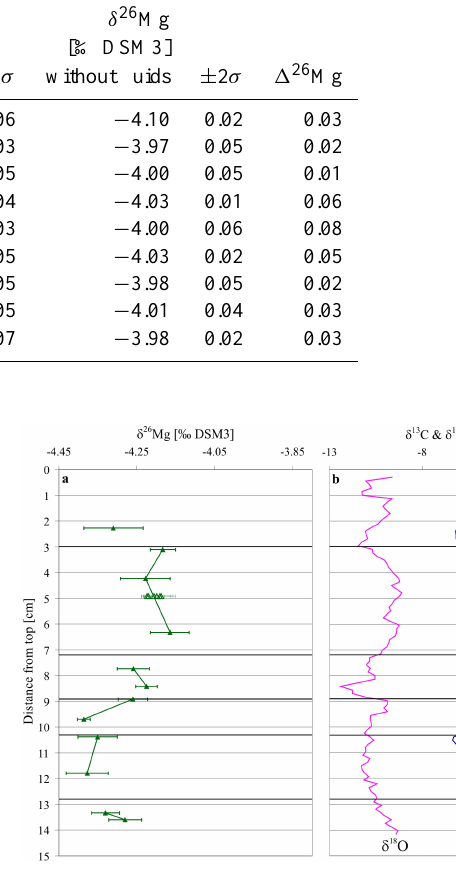
Fig. 6. Magnesium, carbon and oxygen isotope data of stalagmites NC-A and NC-B from Cueva del Tigre Perdido , Peru. (a) Mg- isotope data (NC-A: light green squares; NC-B: green triangles) plotted against age in ka BP using the StalAge model of Scholz and Hoffmann (2011). (b) Carbon (NC-A: dark blue; NC-B: light blue) and oxygen (NC-A: magenta; NC-B: light magenta) isotope data plotted against age in ka BP (data from van Breukelen et al., 2008 and van Breukelen, 2009).